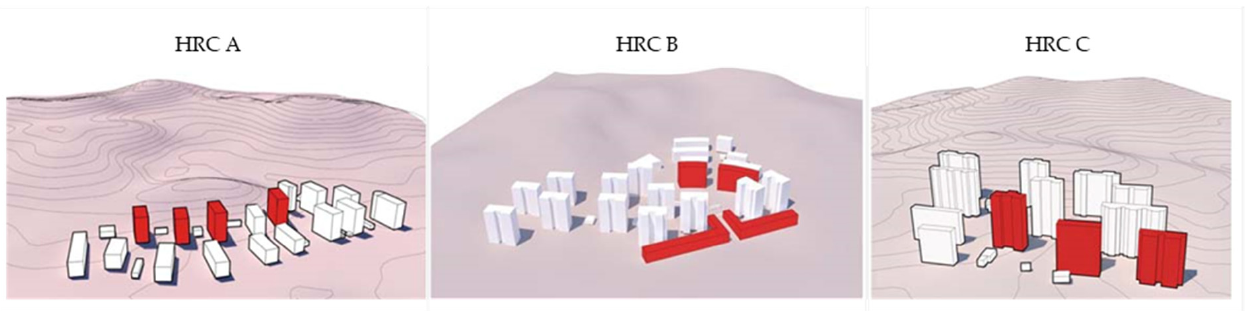
Figure 17. The optimized building dimensions and orientation of HRC A ( left ), B ( middle ), and C ( right ).